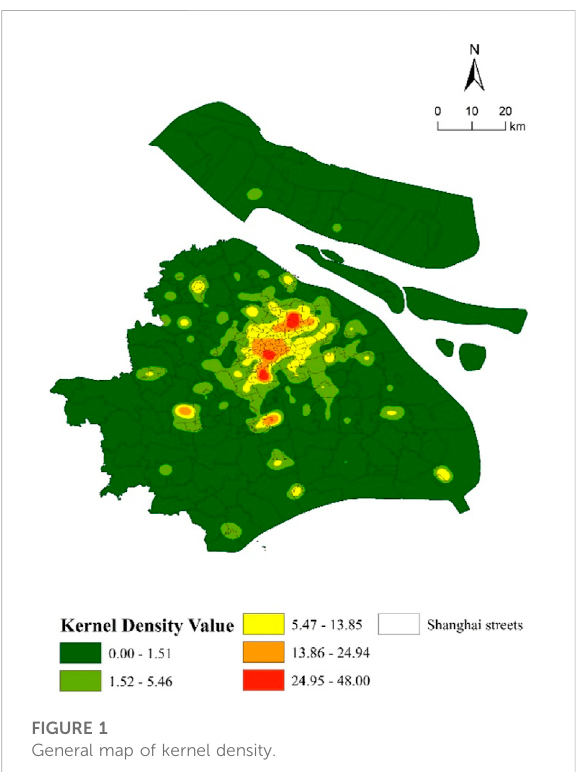
FIGURE 1 General map of kernel